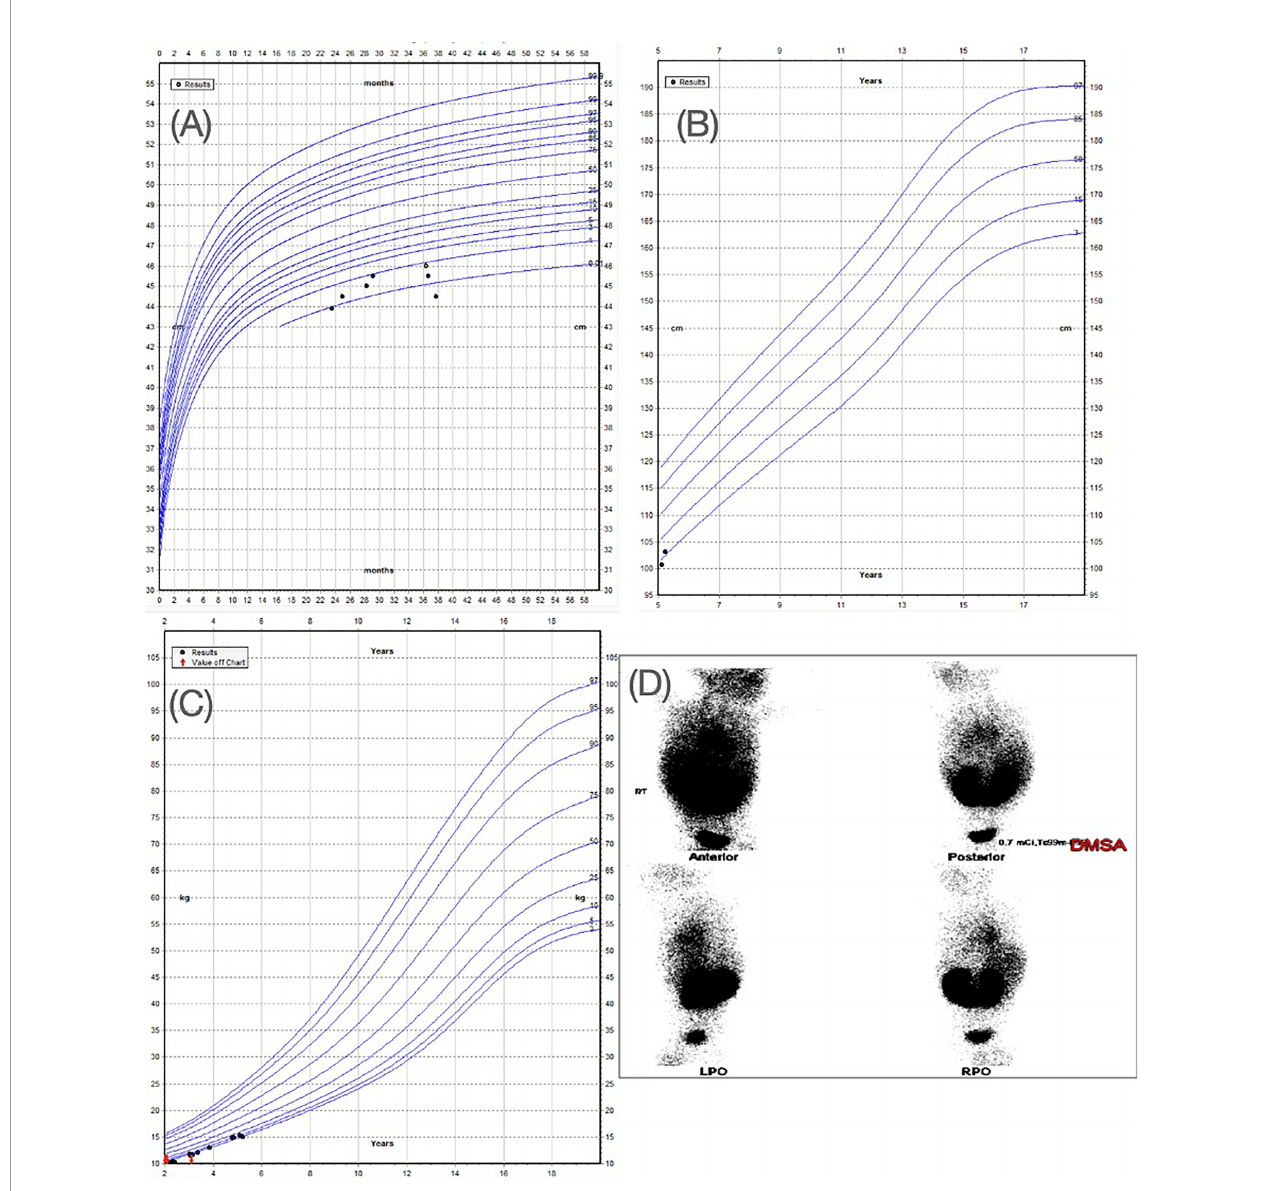
FIGURE 1 | (A) WHO head circumference for boys aged 0-5 years. Head circumference of the patient is indicating a value below 1st percentile. (B) WHO height-for boys aged 5-19 years showing height of the patient below 2nd percentile. (C) WHO Weight for boys aged 2-20 years showing the weight of the patient below the 3rd percentile. (D) Renal DMSA showing horse-shoe kidneys (this panel was previously used in a conference poster for the patient case